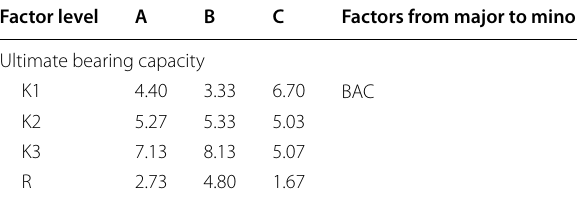
Table 8 Range analysis